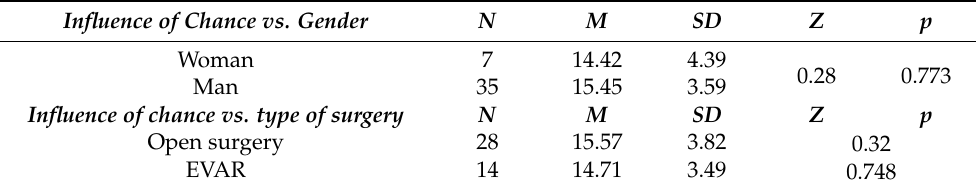
Table 8. Influence of chance vs. gender and type of surgery. Influence of Chance vs. Gender N M SD